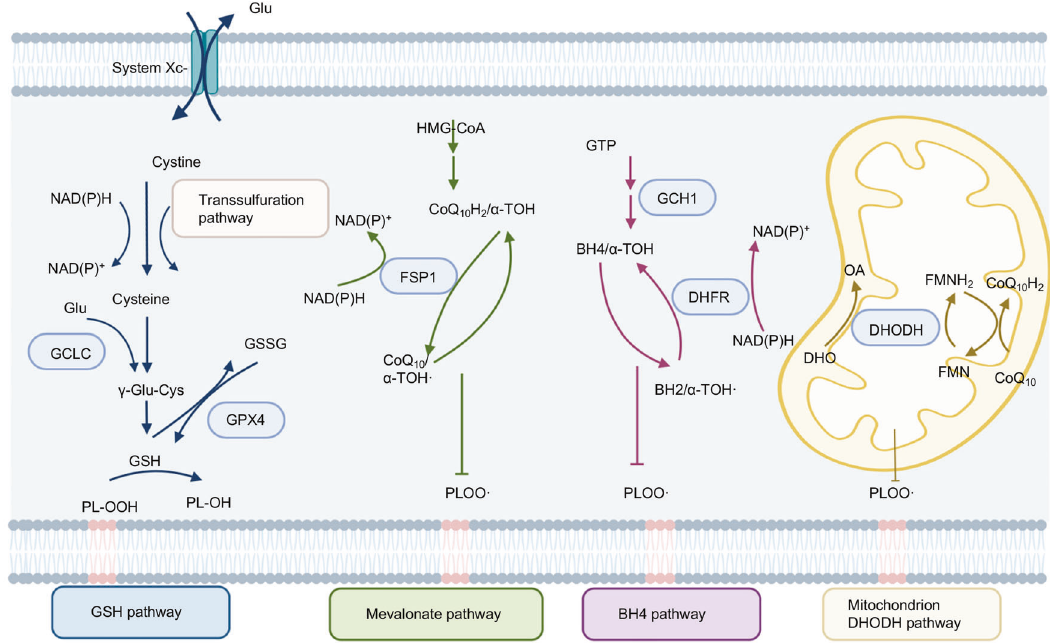
Fig. 2 Ferroptosis defense pathways. The related genes are marked in a blue box. The GSH pathway contains GSH synthesis (GCLC, trans- sulfuration pathway), Glu exporter (System Xc-), and GSH reduction (GPX4). The mevalonate pathway is mainly involved in FSP1-mediated CoQ reduction. BH4 pathway contains GCH1-mediated BH2 synthesis and DHFR-stimulated conversion of BH2 to BH4. DHODH is functional in the